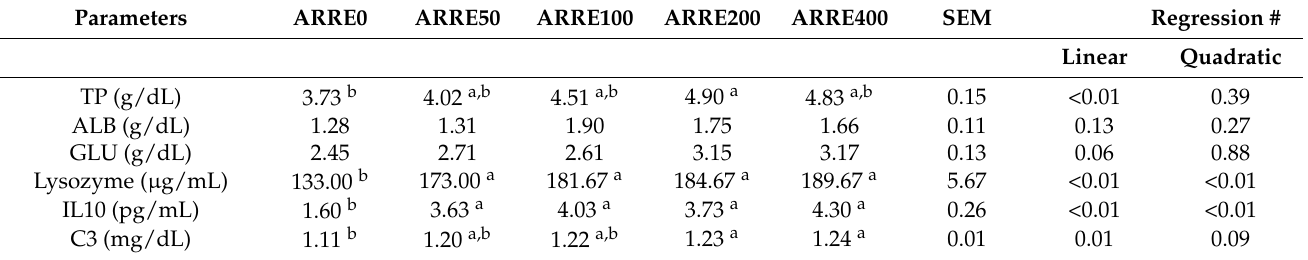
Table 10. The effect of dietary supplementation of ARRE on the immune indices of broiler